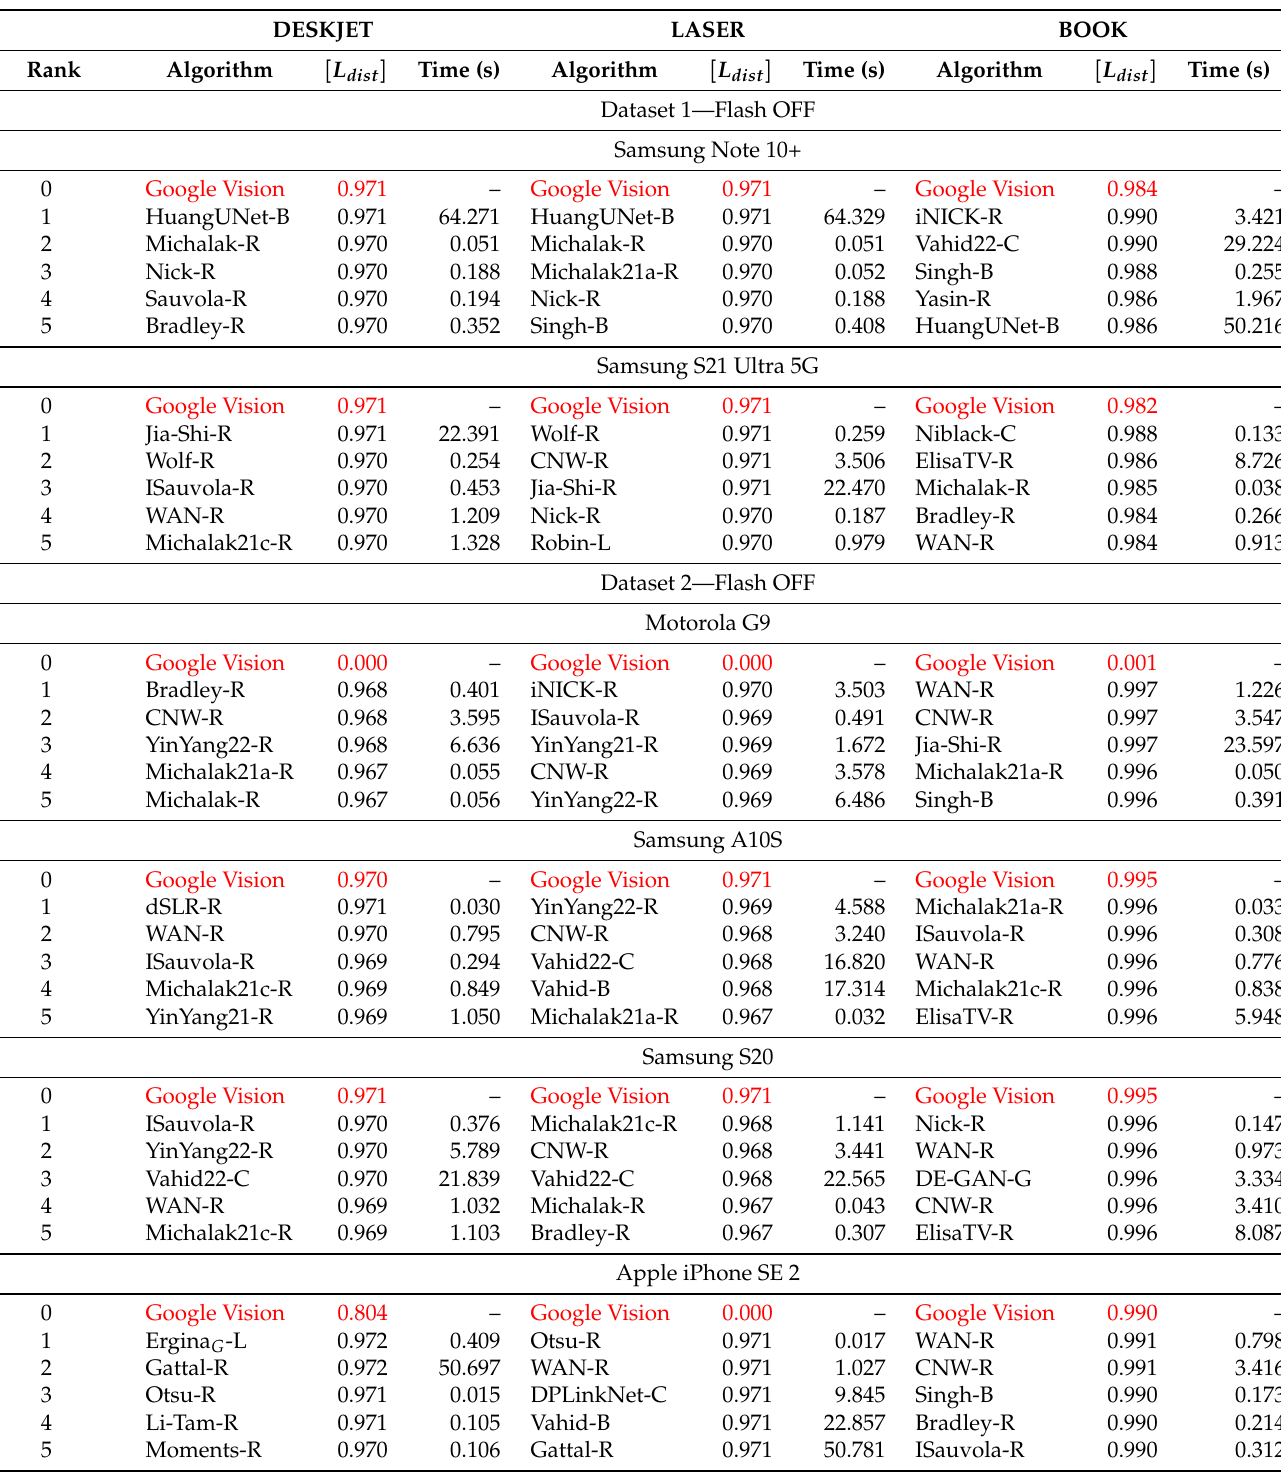
Table 7. Summary of results with Ldist measure and flash OFF sorted according to the quality-time criteria. Note that Google Vision (in red) is not a binarization algorithm, but an OCR